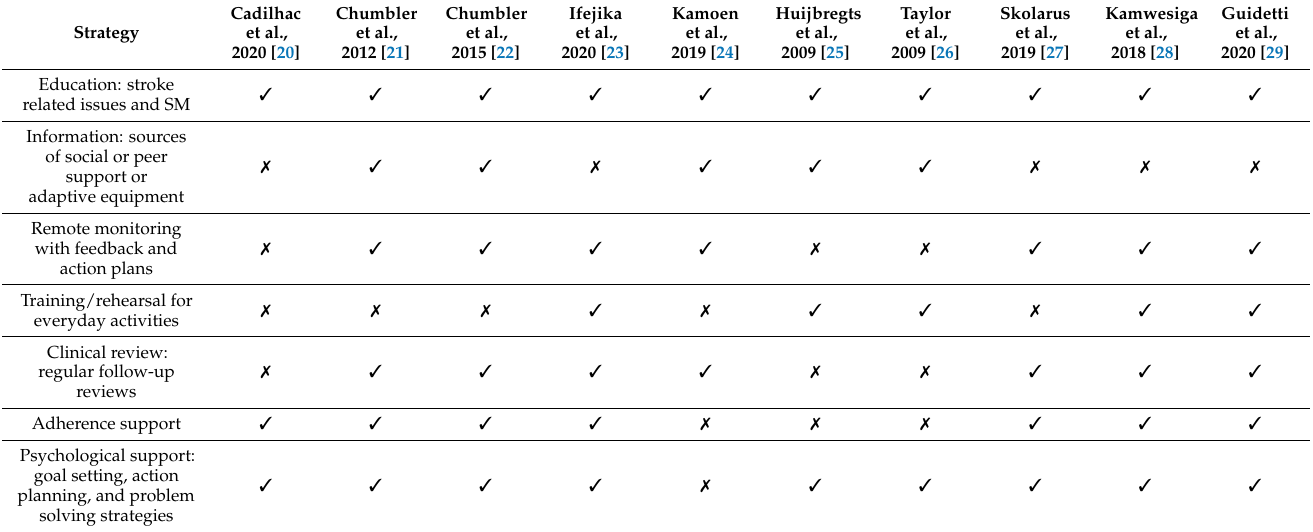
Table 4. SM support